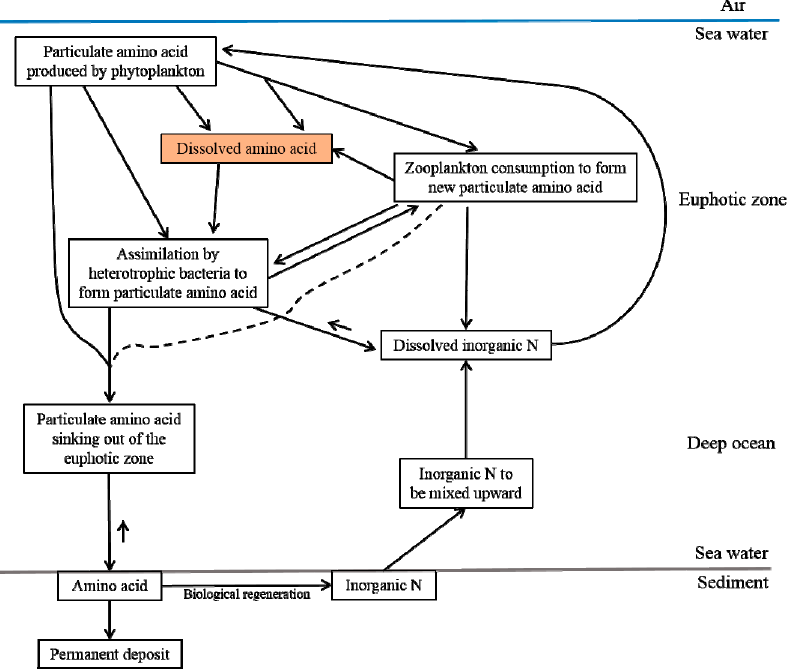
Figure A1. Simplified schematic of the marine organic nitrogen cycle [48] .